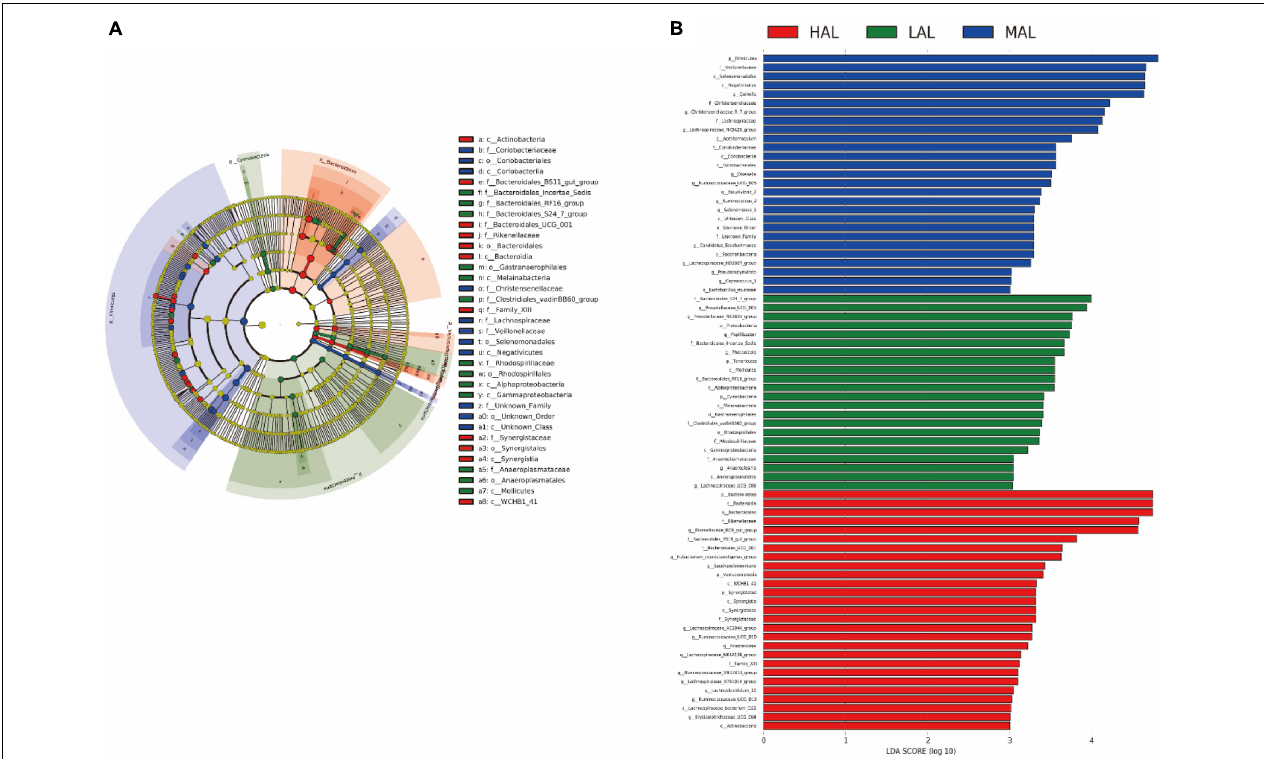
FIGURE 3 | LEfSe analysis of rumen microbiota from yaks inhabiting regions located at distinct altitudes. (A) Histogram of linear discriminant analysis scores based on Classification Information. (B) Linear discriminant analysis effect size cladogram based on Classification Information. HAL, high-altitude region (Zhongba County, Xigatse City; 4,800 m); MAL, medium-altitude region (Nagqu City; 4,500 m); LAL, low-altitude region (Dangxiong County, Lhasa City; 3,800